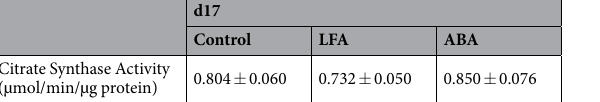
Table 2. Citrate synthase activity in hypothalamus of Control, LFA and ABA mice at d17. Results are means ± SEM (from n = 8/group) and expressed in µ mol/min/ µ g